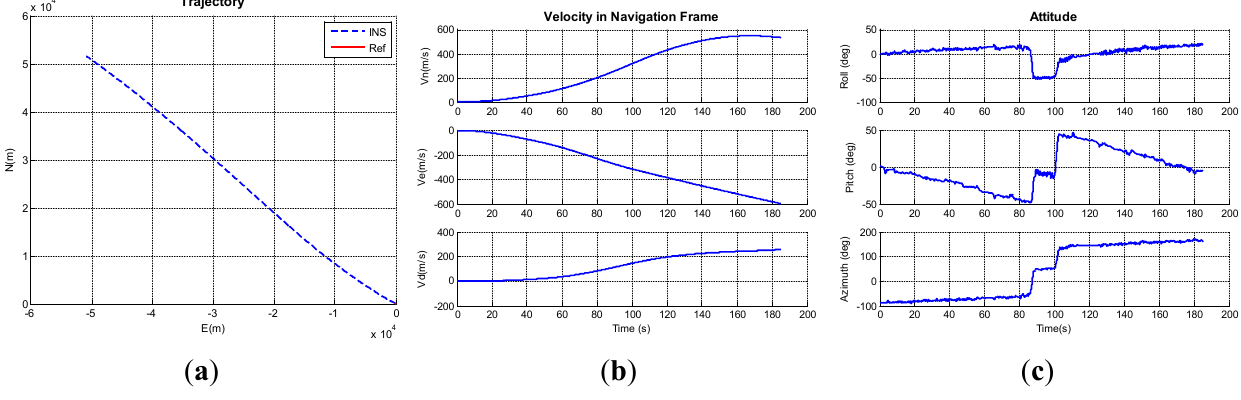
Figure 8. INS navigation solution. ( a ) Trajectory; ( b ) Velocity; ( c )